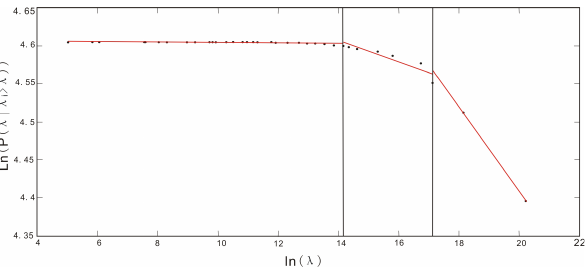
obey the power-law distribution.